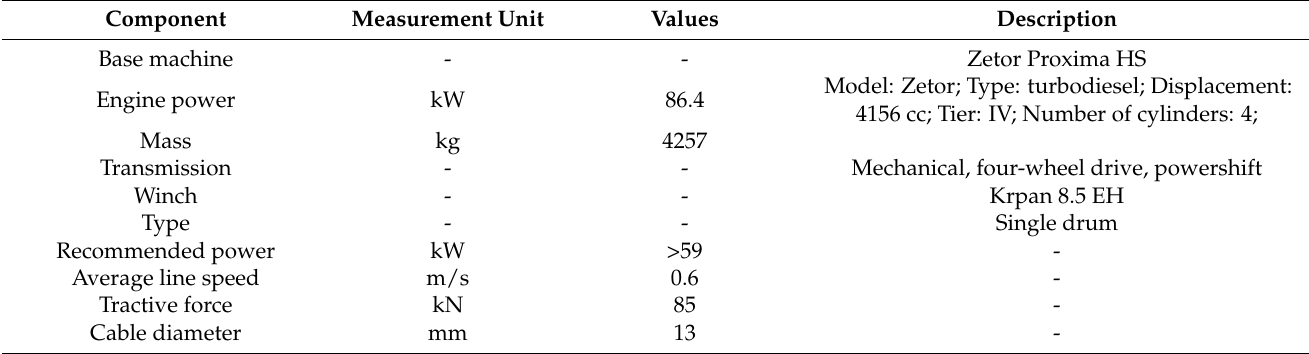
Table 2. Description of the tractor and winch used in both forest